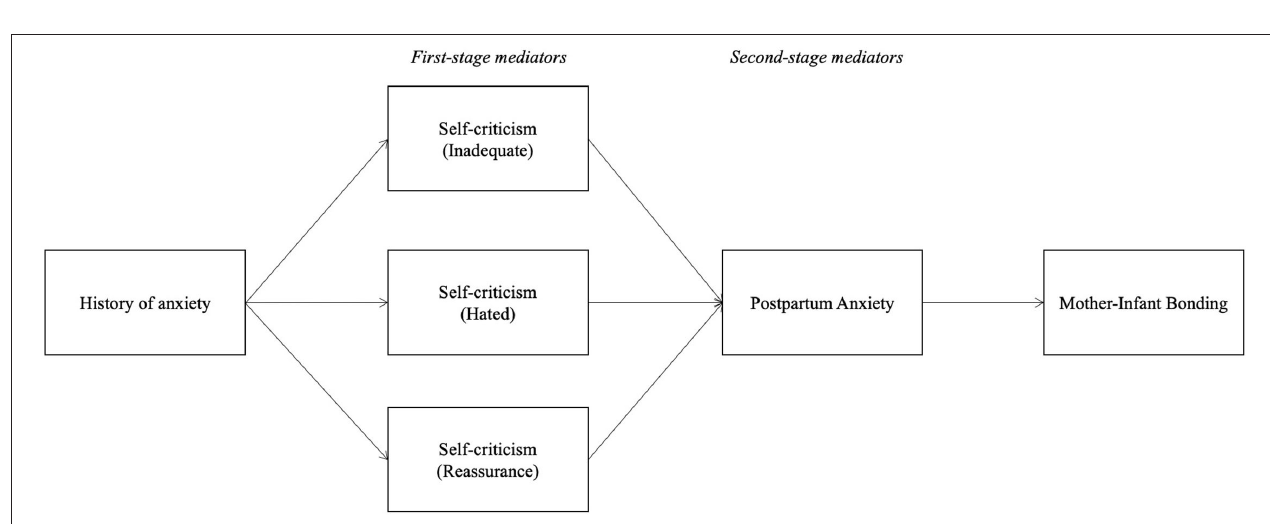
FIGURE 2 | Conceptual mediation model for the presumed influence of history of anxiety symptoms on mother–infant bonding, through self-criticism and postpartum anxiety symptoms.